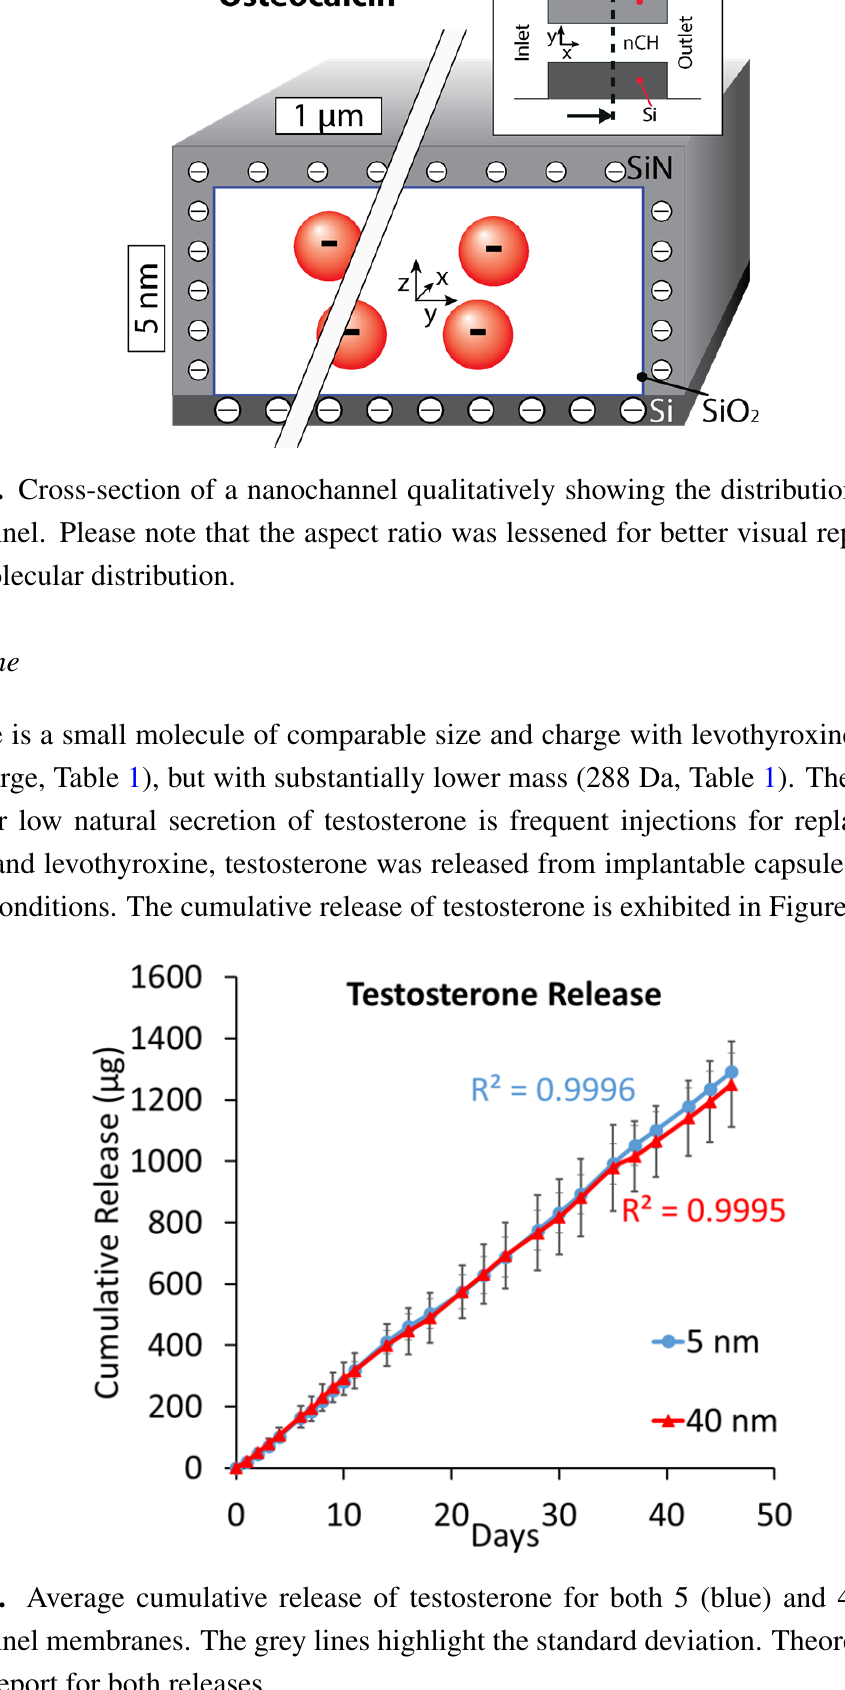
Figure 3 . Average cumulative release of osteocalcin from 3 and 5 nm nanochannel membranes ( n = 3). Experimental points were collected every 12 h for 10 days.